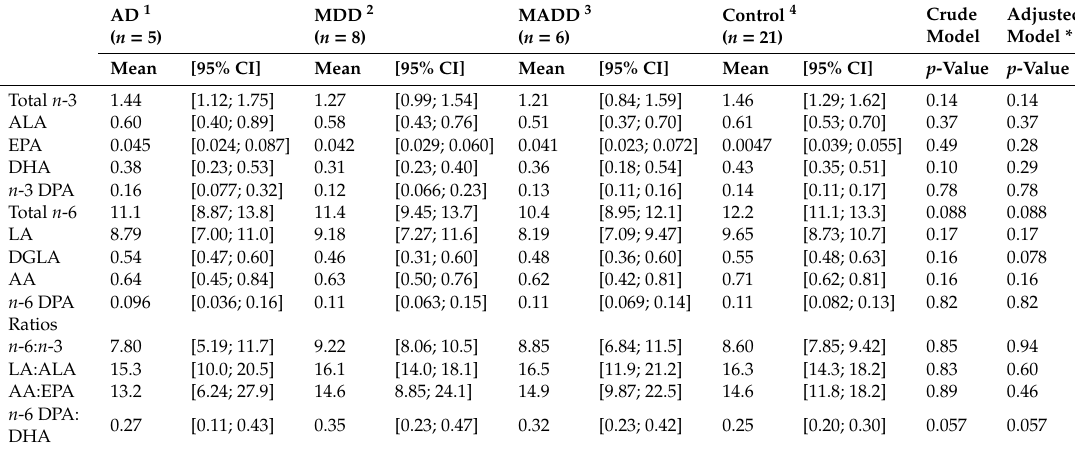
Table 3. Means [95% CI] and simple contrasts ( p -values) between cases (AD + MDD + MADD) and controls for omega-3 polyunsaturated fatty acids ( n -3 FA), n -6 FA and n -6: n -3 FA ratios in human milk in the first week postpartum. Skewed data were log-transformed and are presented on the original (back-transformed) scale. Means [95% CI] are presented as % FA of total